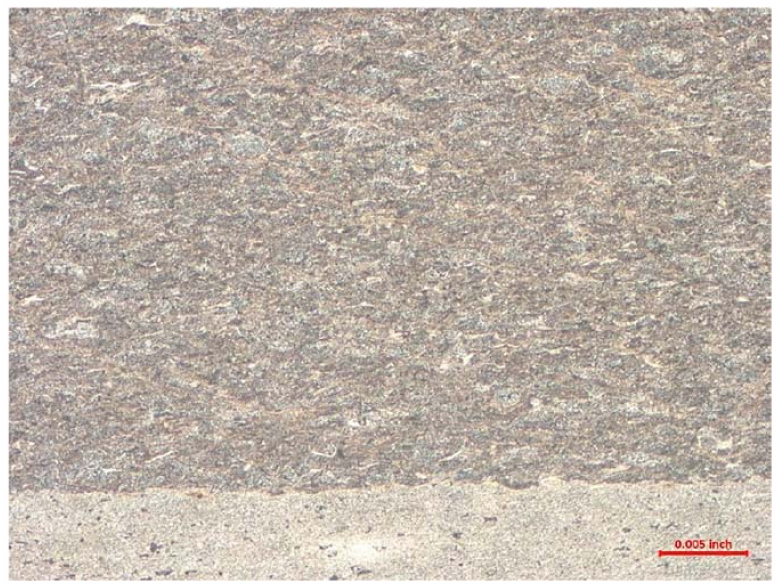
Figure 9. Micrograph depicting the typical microstructure observed on Al-2024 cold-sprayed coating on Al-2024 substrate. As-etched; at 100 ×